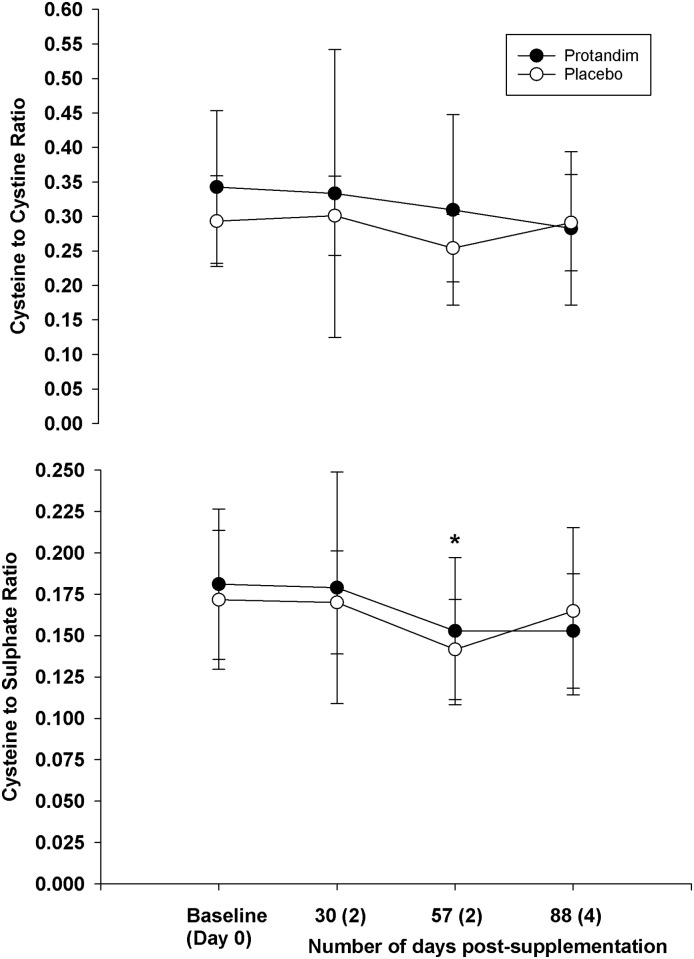
The long terms effects of supplementation on the cysteine to cysteine ratio and the cysteine to sulfate ratio (rest, fasted state).There was no difference between groups for either variable (p = 0.30 for the cysteine to cysteine ratio, p = 0.69 for the cysteine to sulfate ratio). For the cysteine to sulfate ratio, there was a difference at 57 days post-supplementation compared to baseline (p = 0.00). Mean values represented by circles, error bars represent SD.